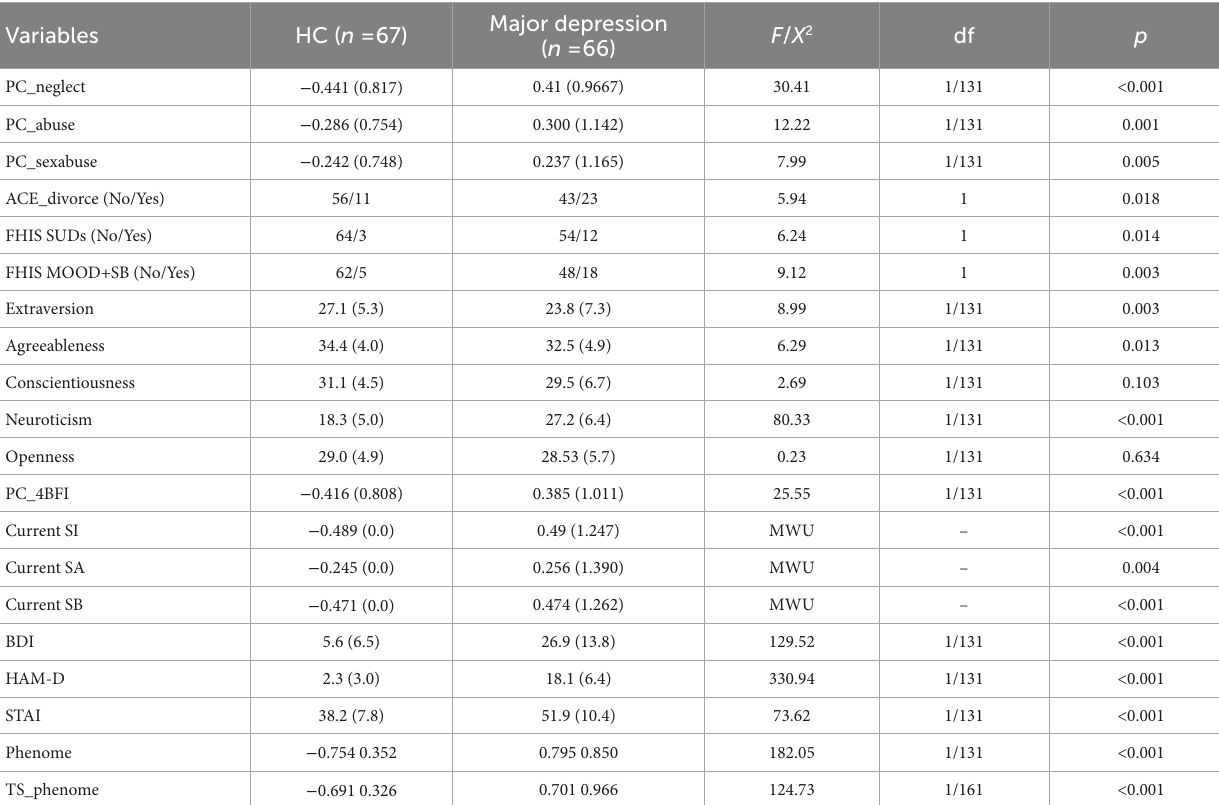
TABLE 3 Clinical features of major depressive disorder (MDD) and healthy controls (HC), including adverse childhood experiences (ACE), personality dimensions as assessed with the Big Five Inventory (BFI), assessment of depression and anxiety severity, and lifetime and current suicidal behaviors.